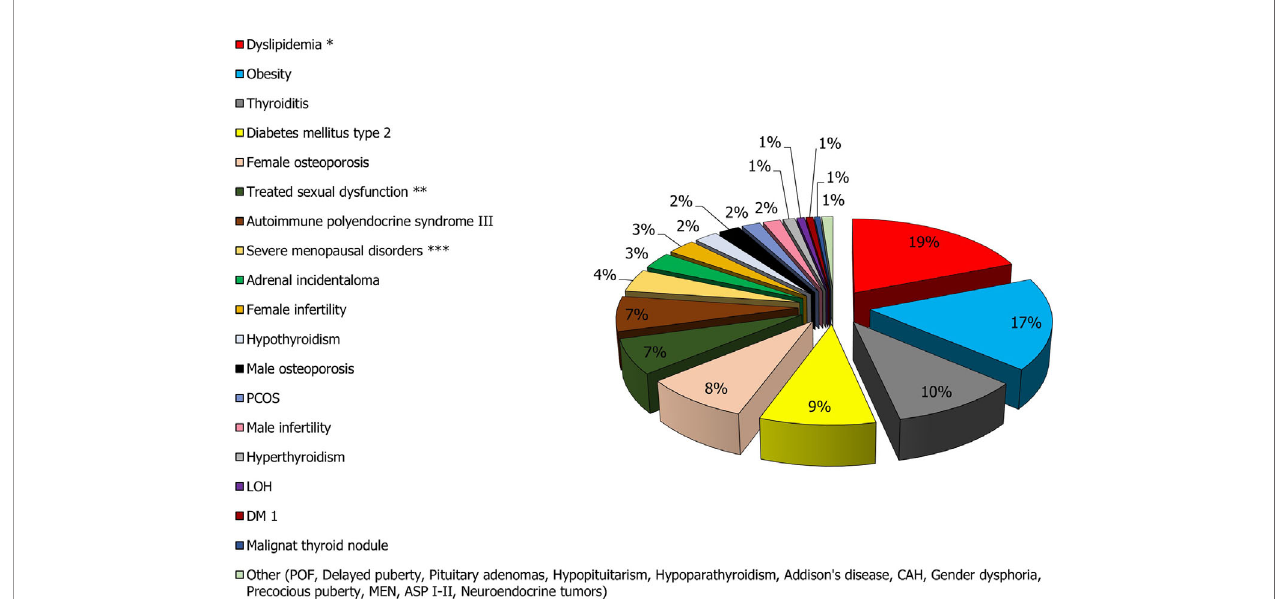
FIGURE 2 | Prevalence of the main endocrine diseases in the Italian population. *The prevalence of hypercholesterolemia (the most frequent condition) was considered in the calculation. **The total prevalence of sexual dysfunction is much higher than that of other conditions such as dyslipidemia and obesity. However, only 7% of men and women with sexual dysfunction are treated or otherwise see a physician for treatment of the disorder. ***Menopause affects approximately 10,000,000 women. Of these, 80% report complaints related to the condition, but only 25% seek medical attention.